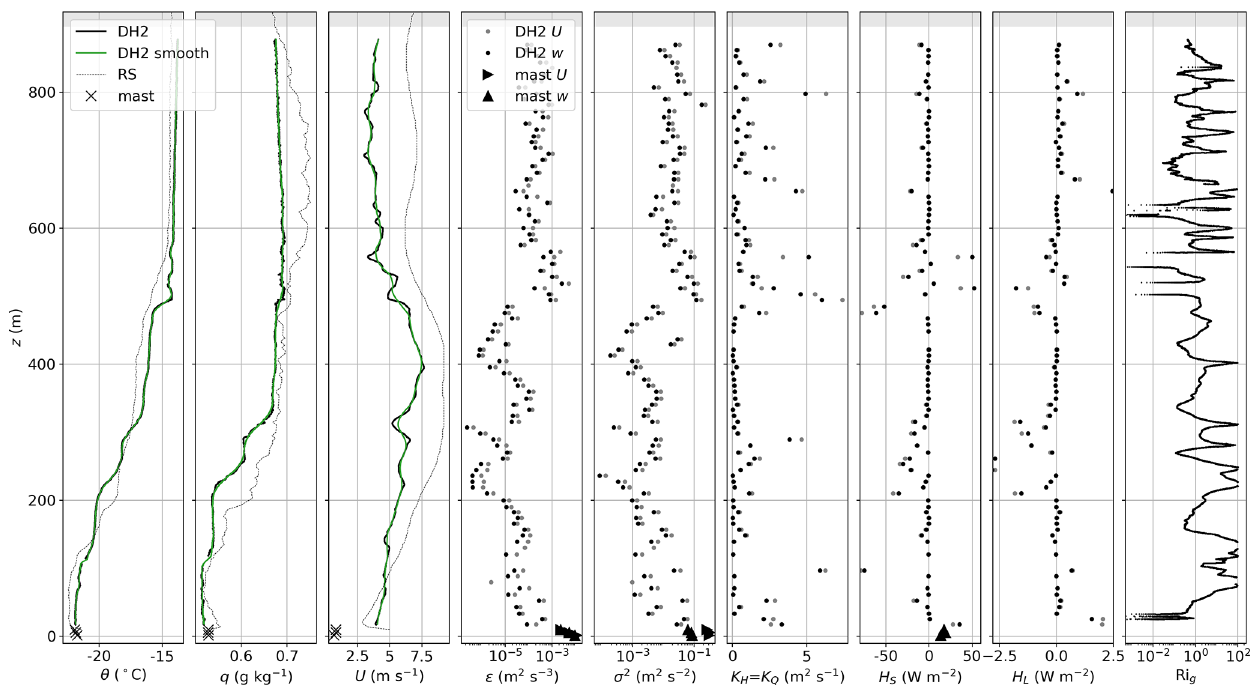
Figure 11. Vertical profiles for 9 April (descent). Panels are as in Fig.